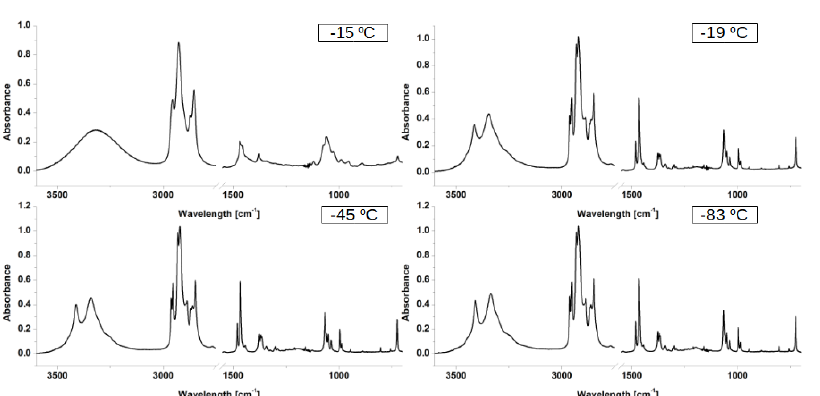
Figure 3. IR spectra of n-octanol measured at various temperatures. The range from 2750 to 1650 cm − 1 was omitted for clarity due to the lack of significant bands. Liquid state spectrum: − 15 ◦ C (258 K), solid state spectra: − 19 ◦ C (254 K), − 45 ◦ C (228 K), and − 83 ◦ C (190 K).